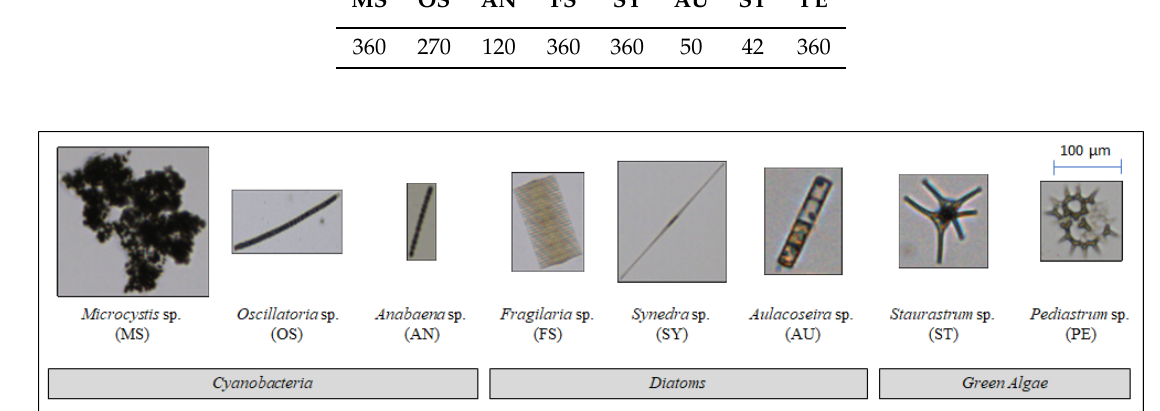
Figure 8. Algal images used for a CNN model